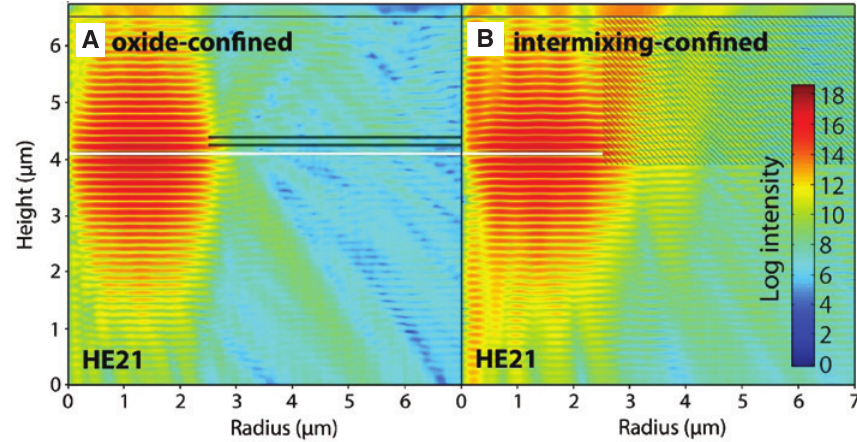
Figure 12: Simulated cross-section of the electric field intensity distribution of the first excited mode (HE21) in 5 μ m aperture (A) oxide-confined and (B) intermixing-confined devices. White lines represent the active region, thick black lines point to the oxide apertures, and hatching marks the area where the material was intermixed. Thin black line on top of the VCSEL represents the surface of the